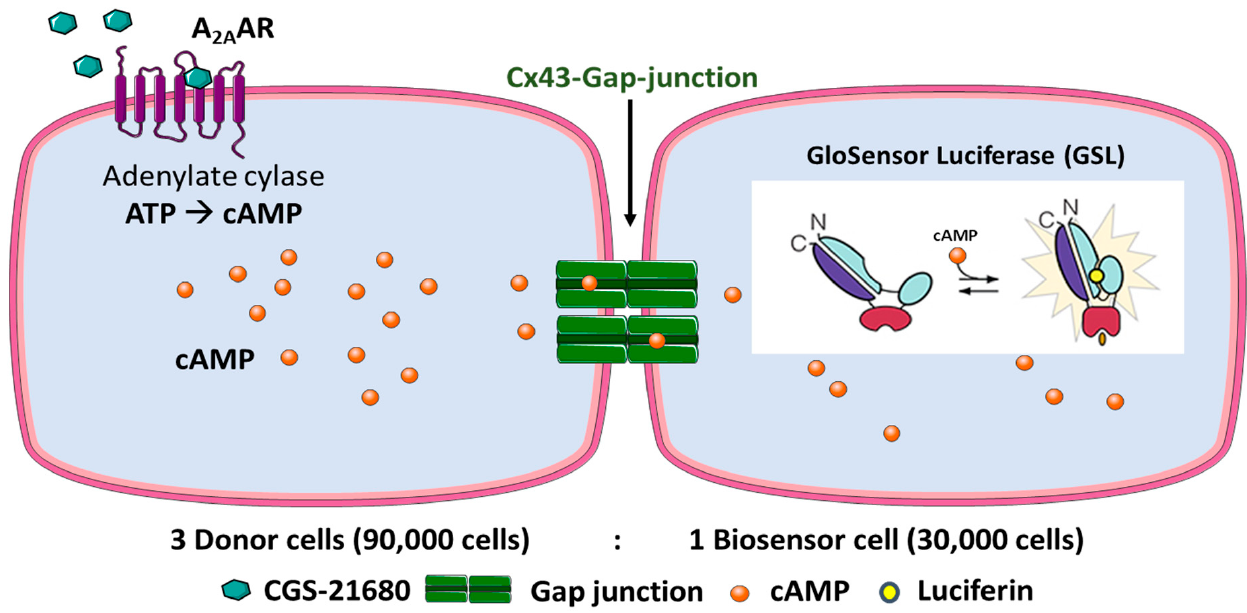
Figure 2. Design of the Cx43 GJ assay. HeLa cells expressing A 2A AR and Cx43 are denoted as donor cells and HeLa cells expressing GloSensor luciferase and Cx43 as biosensor cells. The cell lines were cocultured in a ratio of 3:1 (donor: biosensor cells) for 4 h to allow the formation of Cx43 GJs. The cells were then equilibrated with buffer containing the substrate (luciferin) of the engineered cAMP-dependent luciferase. Upon activation of the G s protein-coupled A 2A ARs, cAMP levels in the donor cells are increased. cAMP can then migrate via the Cx43 GJs to the biosensor cells. There, cAMP binds to the GloSensor luciferase which results in a conformational change that leads to an activation of the GloSensor luciferase, creating a luminescence signal by oxidation of luciferin. Depiction of GloSensor luciferase is based on reference